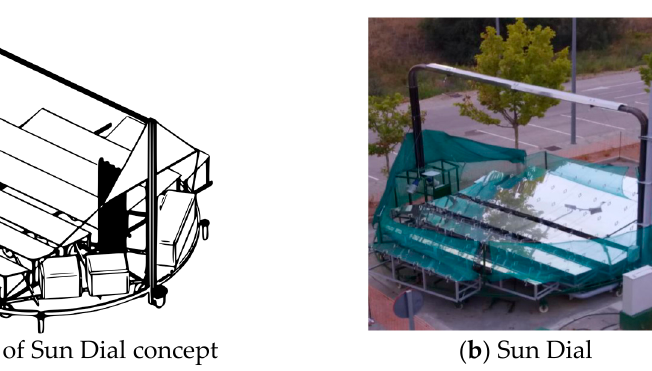
Figure 2. The left image ( a ) shows the concept for the Sun Dial construction. The right image ( b ) is a photograph of a constructed Sun Dial, showing the distribution and relative position of the mirrors in relation to the axis of rotation and the receiver.